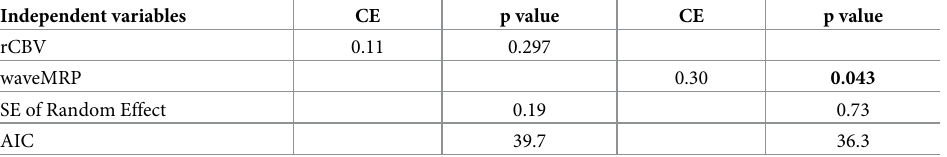
Table 2. Predictors of CD31 positivity. Mixed logistic regression with CD31 dichotomized to no or present staining as outcome and either rCBV or waveletMRP as predictor for all included matching tissue samples. Independent